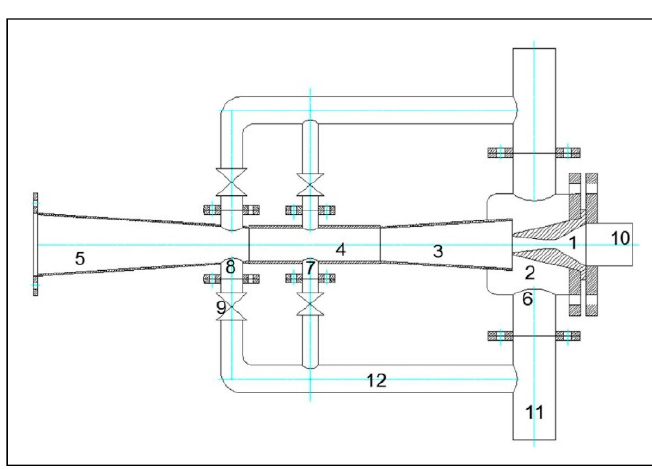
Figure 8. Bypass ejector [36].